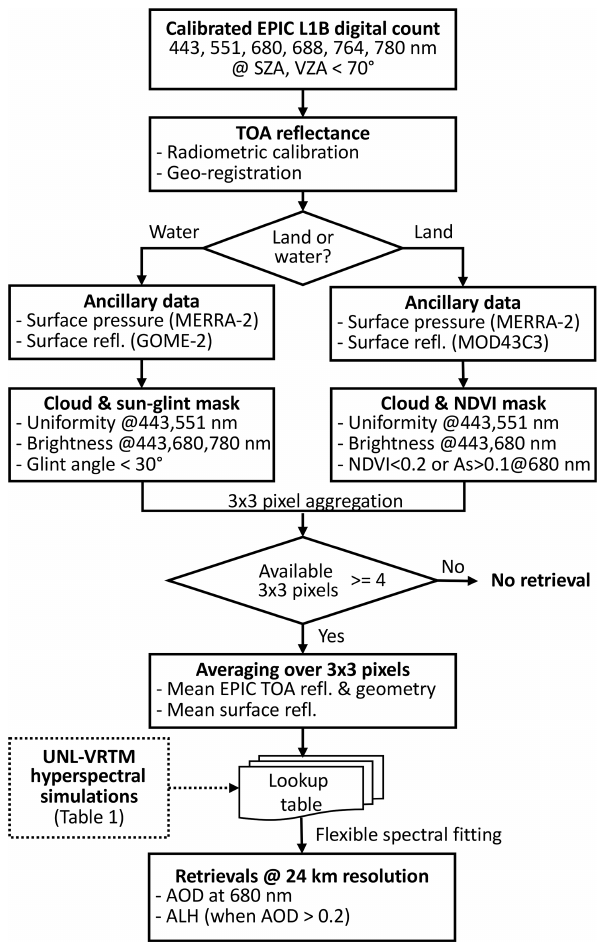
Figure 5. Flowchart of the AOD–ALH retrieval algorithm. the number of available pixels within a box is not less than four (of the total of nine), calculate mean values of TOA reflectance, satellite geometries, and surface re- flectance for the available pixels. Otherwise, do not con- duct an aerosol retrieval for the